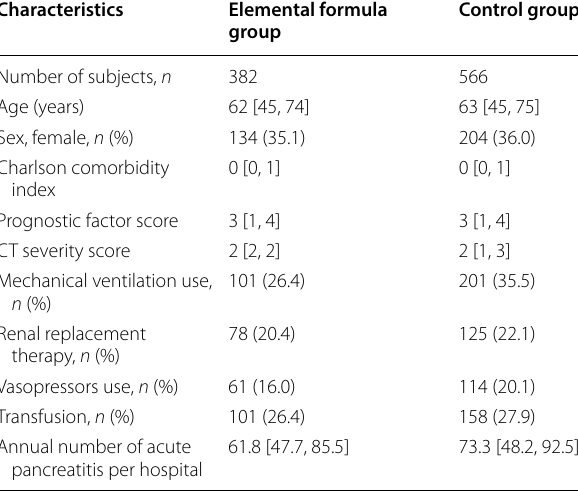
Table 1 Patient